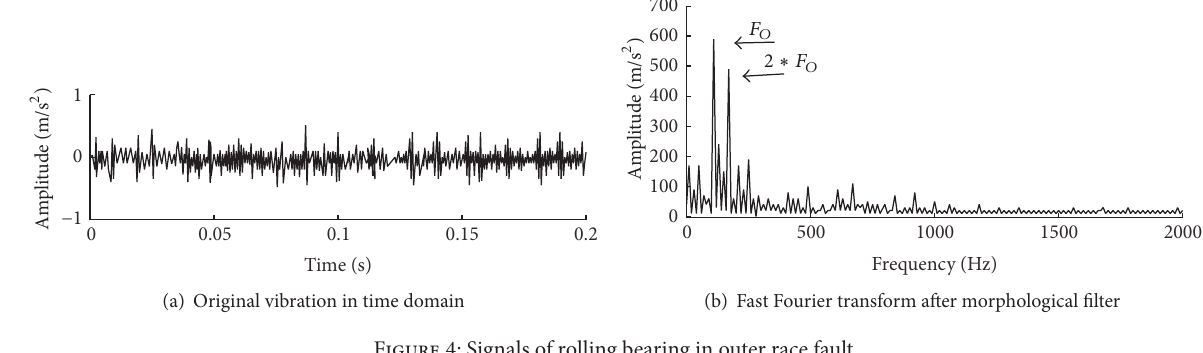
Figure 4: Signals of rolling bearing in outer race fault.